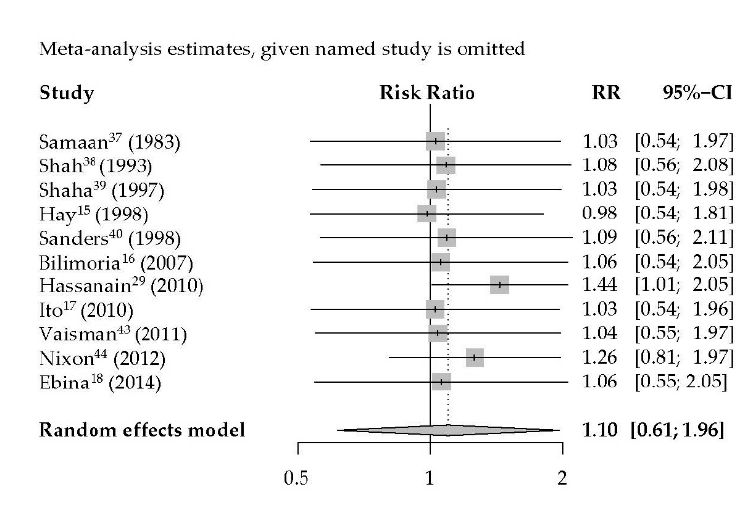
Figure 4. Sensitivity analysis for recurrence rates of well-di ff erentiated thyroid carcinoma after thyroid lobectomy versus total thyroidectomy. DFS, OS and DSS showed no extreme e ff ect and were not